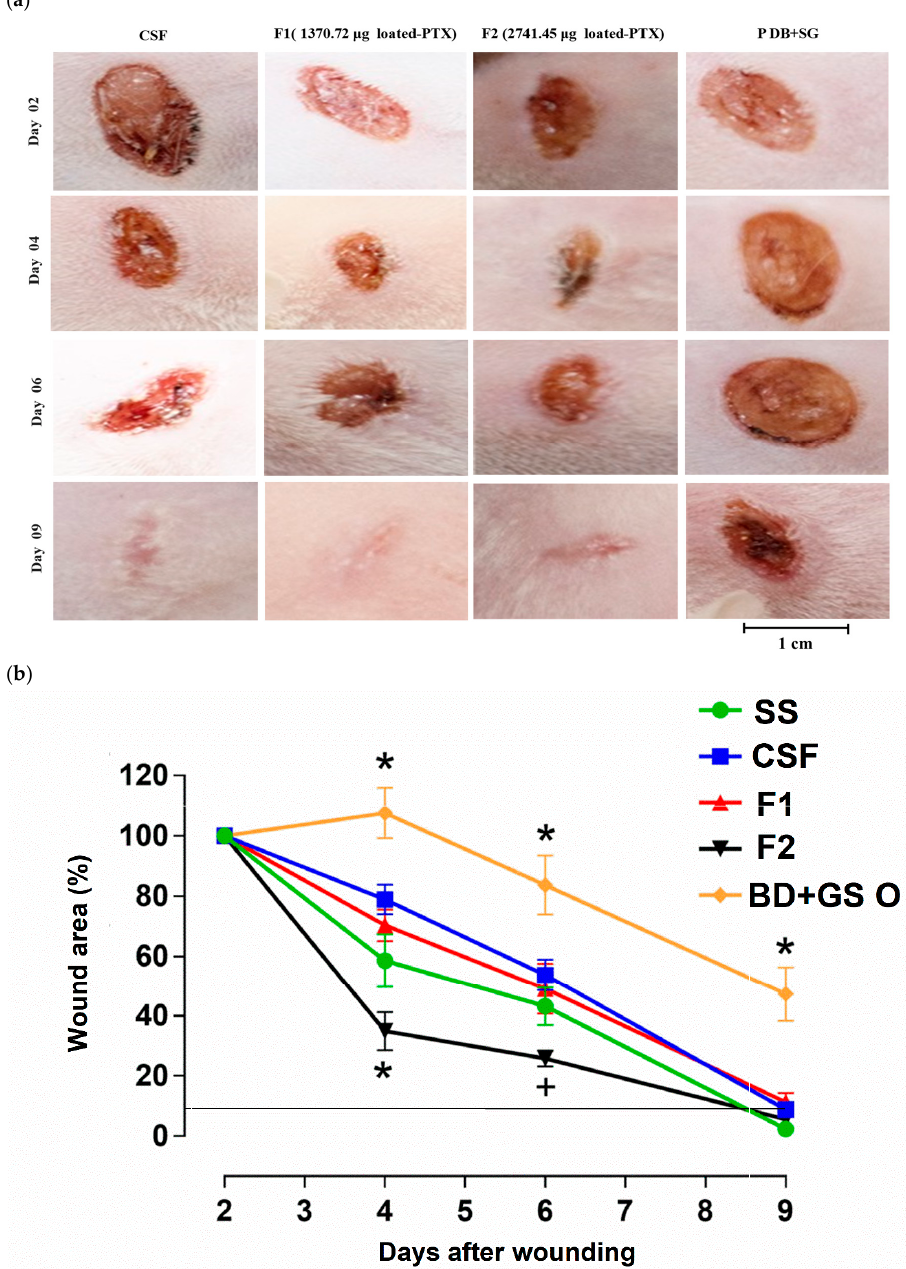
Figure 6. Wound healing process: ( a ) photographs of mechanical wounds of the four groups during the wound healing treatment period at 2, 4, 6 and 9 days; ( b ) percentage of wound area reduction from 2, 4, 6, and 9 days. Data are expressed as mean ± SD ( n = 7) and * p < 0.05 different from all other groups; + p < 0.05 different from CSF (chitosan films), F1, BD + GS O groups; one-way ANOVA followed by the Neuman–Keuls test.